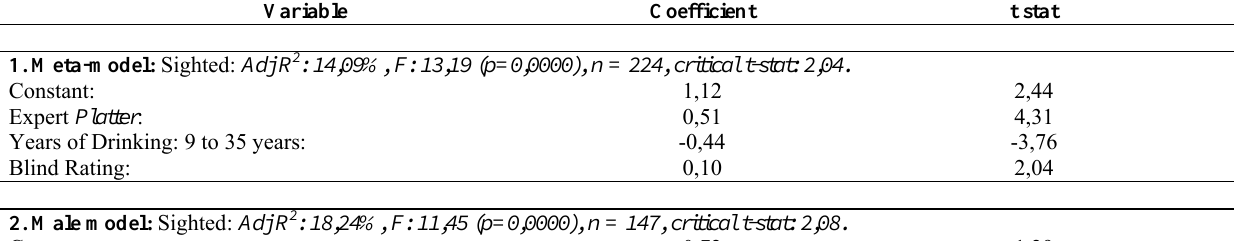
Table 4: Estimated step-wise regressions explaining sighted wine assessments Variable Coefficient t